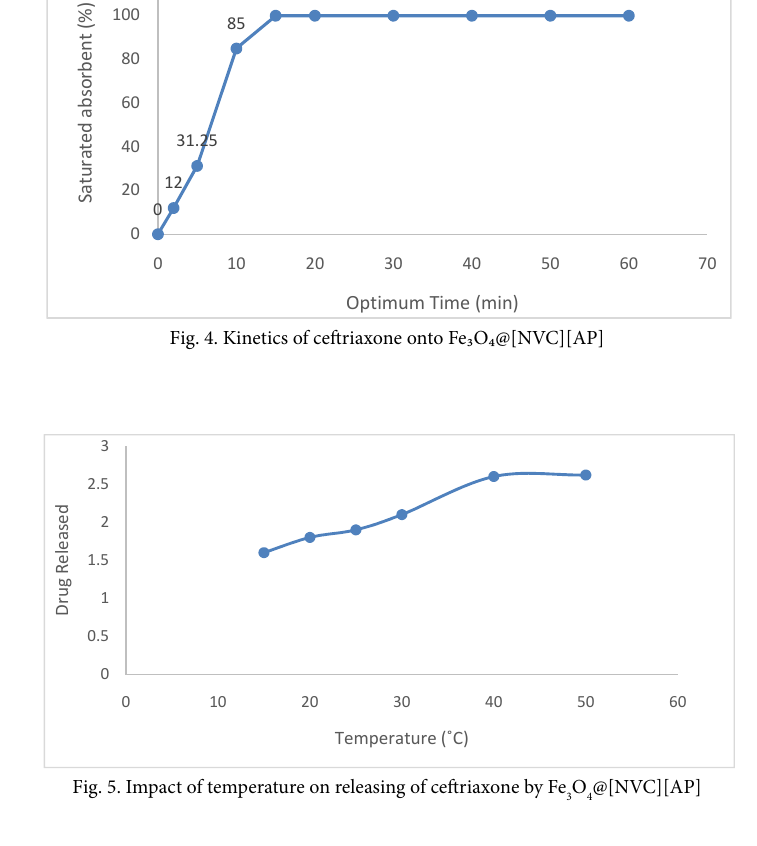
Fig. 5. Impact of temperature on releasing of ceftriaxone by Fe 3 O 4 @[ NVC ][AP]